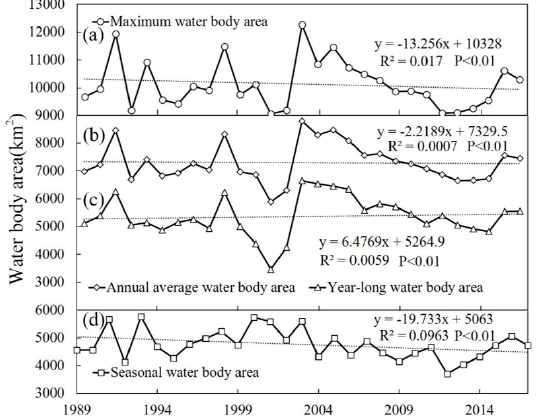
Figure 6. The water area distribution in the Huai River Basin from 1989 to 2017: ( a ) The maximum water body; ( b ) the average water body; ( c ) the year-long water body; ( d ) seasonally changing water body.